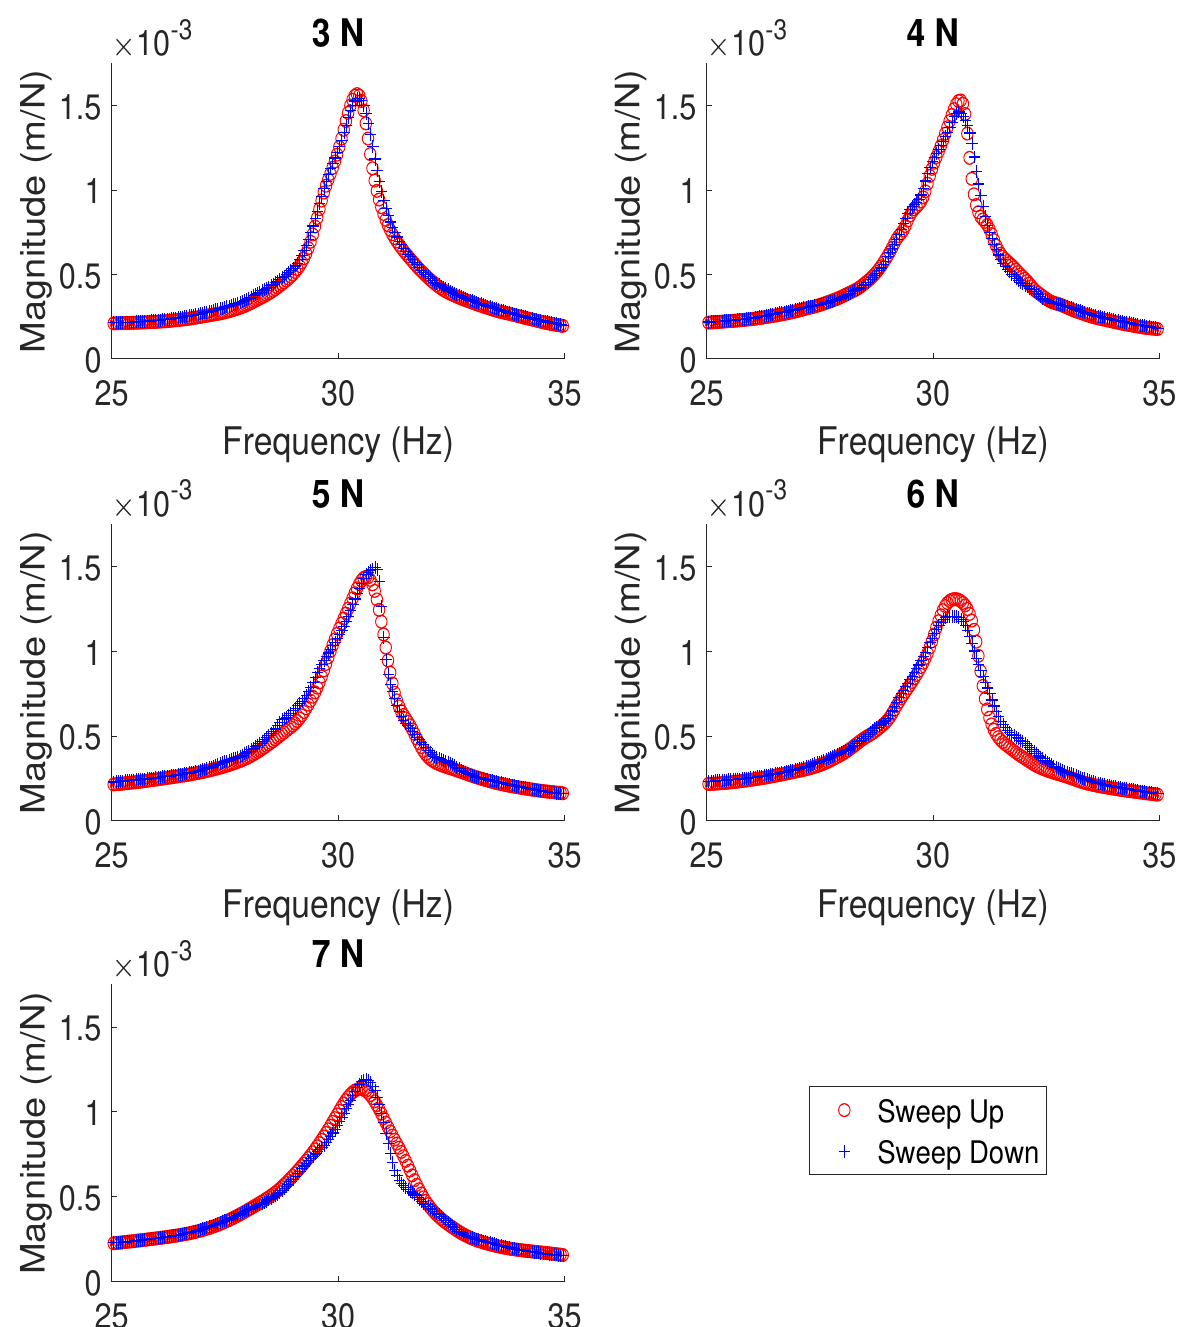
Figure 5. Results pertaining to the second resonance frequency of the structure for five different excitation force magnitudes, sweeping both up and down the frequency